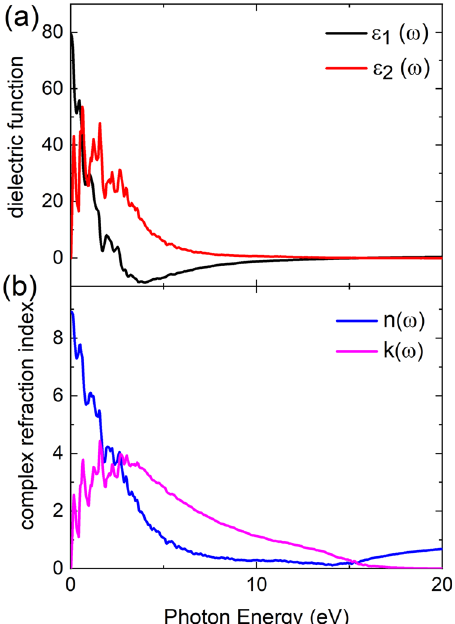
Fig. 4 Ab-initio optical response of the GeSN bilayer for in-plane light polarization. a Real and imaginary parts of the dielectric function for the GeSn-bilayer, ε 1 ( ω )(in black) and ε 2 ( ω ) (in red). b Real and imaginary parts of the refractive index for the GeSn-bilayer, n ( ω ) (in blue) and k ( ω ) (in pink).